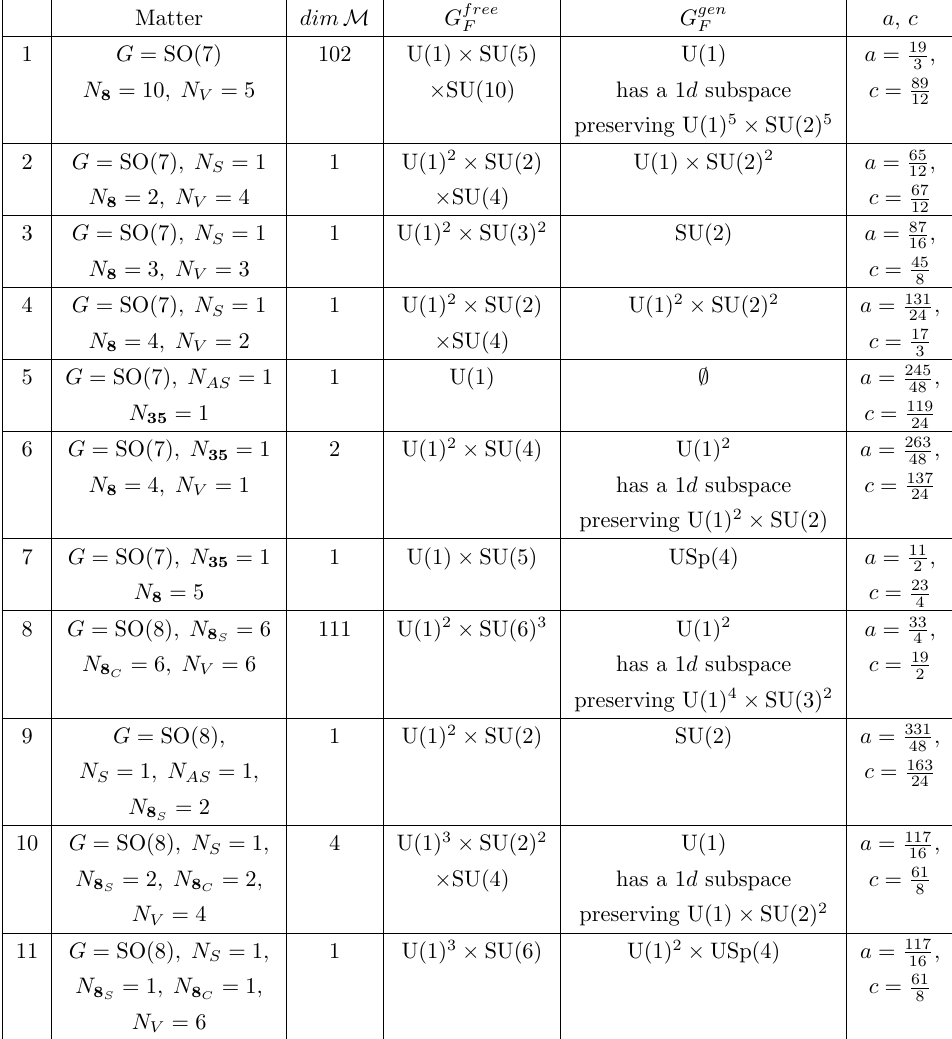
Table 20 . Cases involving an SO(7) or SO(8) gauge group with ‘exotic’ matter. (cid:15) In case 2 one of the SU(2) is the one rotating the spinors, while the other is embedded in SU(4) as SO(3) (cid:2) U(1) (cid:26) SU(4). The U(1) is a combination of the intrinsic U(1) groups and the commutant of the SU(2) in